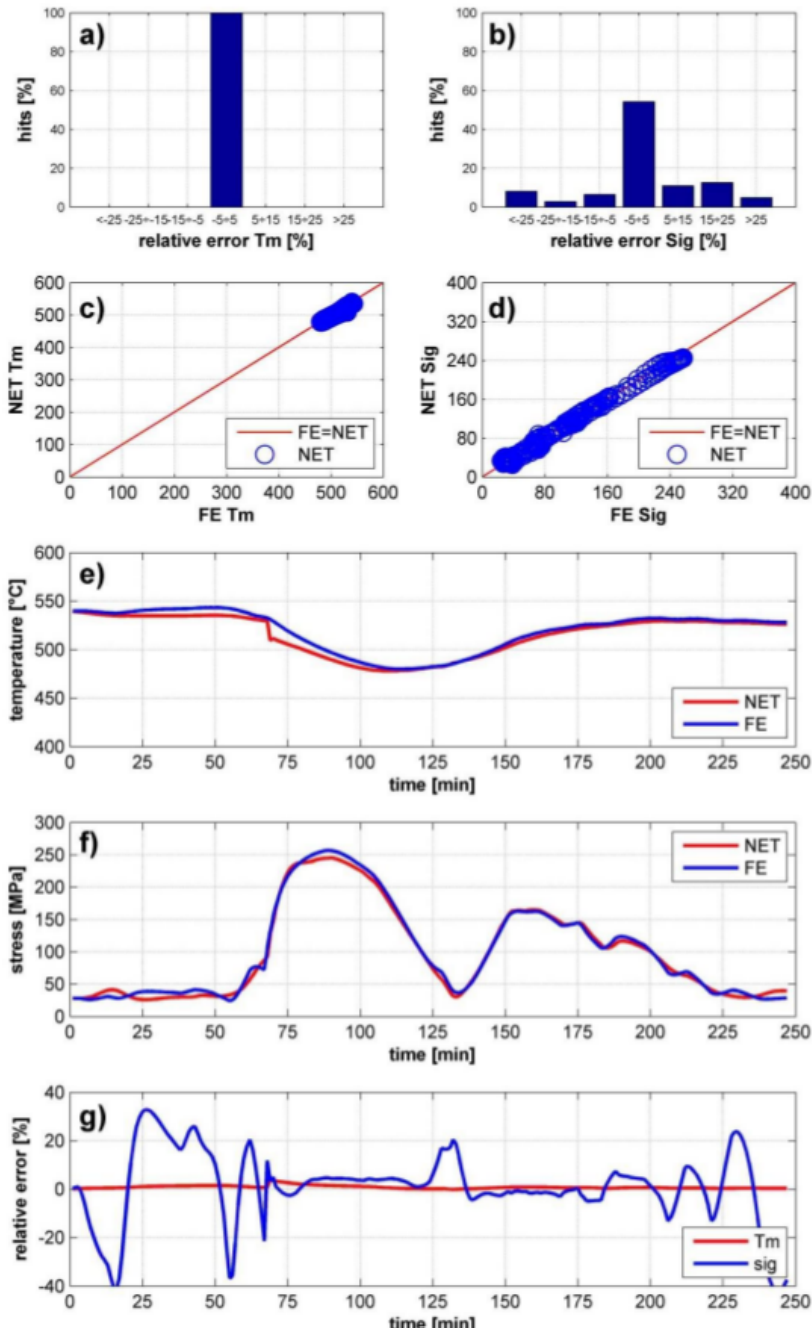
Figure 10: Result of neural network tests for load rejection and turbine